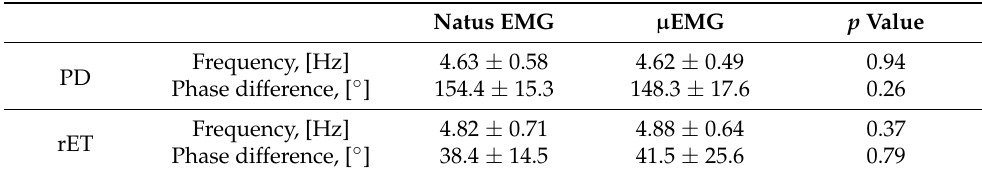
Table 2. Comparison of frequency and phase difference measurements in patients with Parkinson’s disease and in patients with rET.